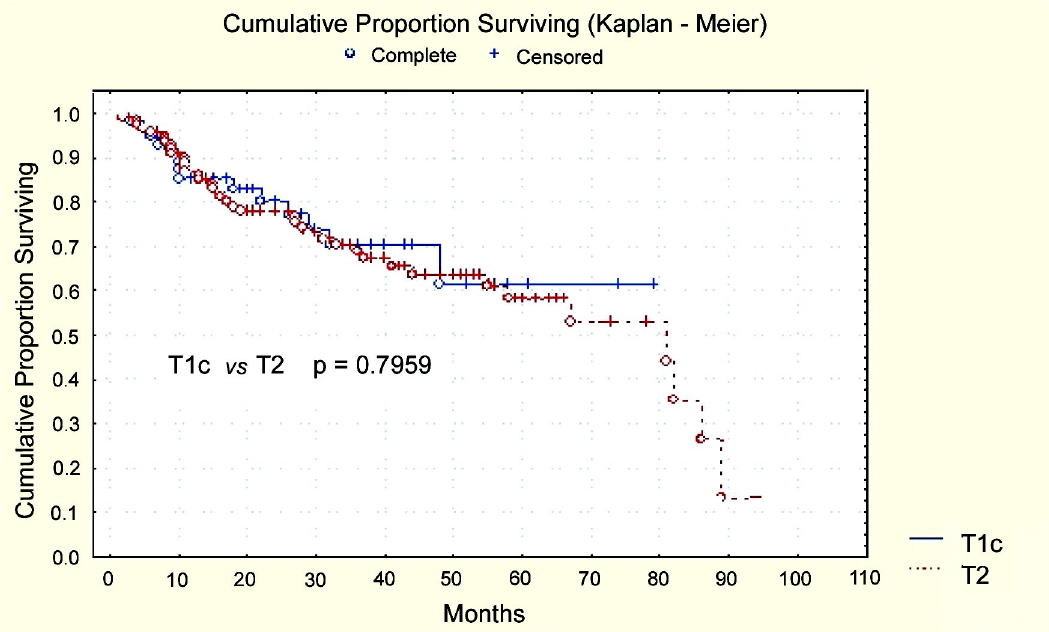
Figure 1 – Time to PSA progression according to clinical stages T1c and T2. Kaplan-Meier product-limit analysis.